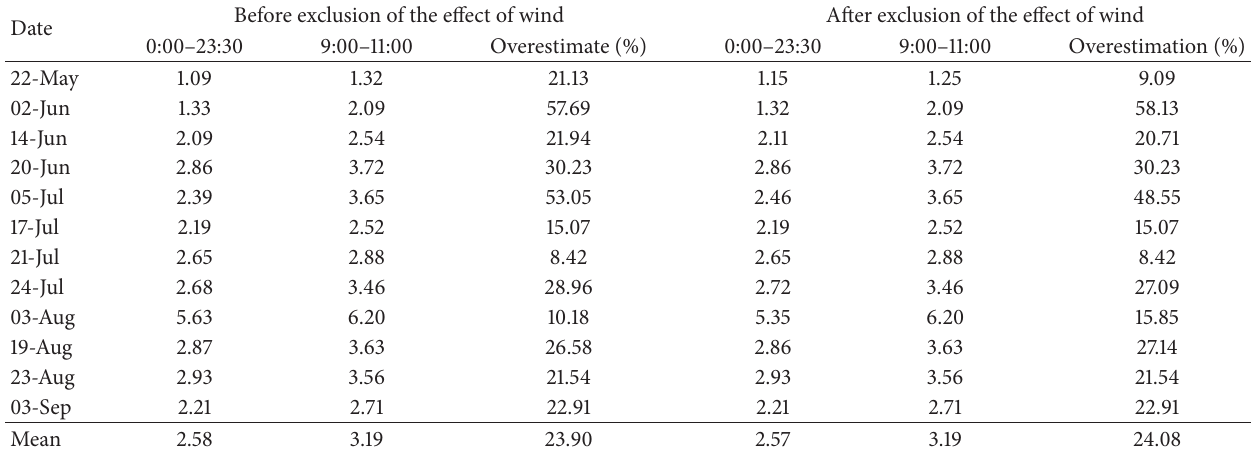
Table 1: Daily mean values of Re calculated from 9:00 to 11:00h a.m. local time and from 0:00 to 23:00 h before and after exclusion of the effect of wind.